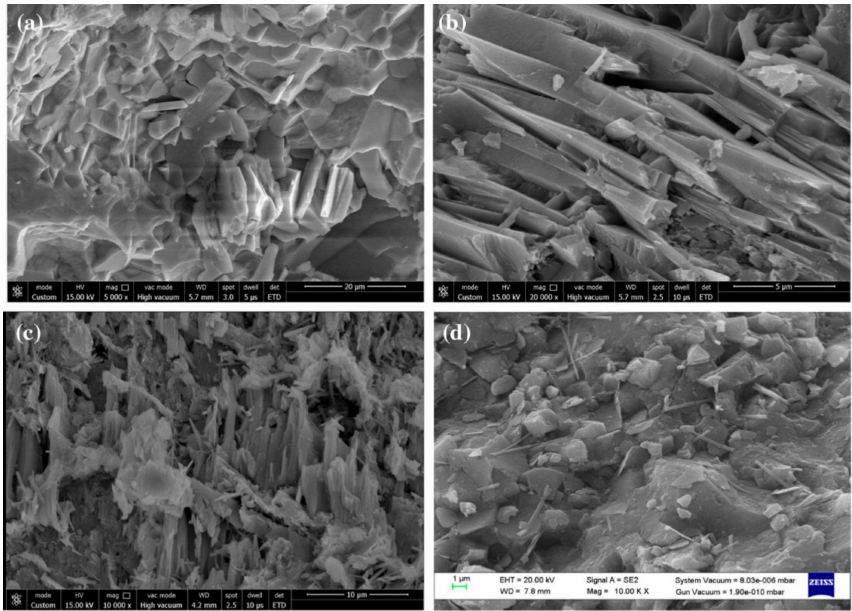
Figure 35. FE-SEM images of CNC specimens incorporating ( a ) 0.02% SP@GO, ( b ) 0.04% SP@GO, ( c ) 0.08% SP@GO and ( d ) 0.16% SP@GO at curing age of 28 days. Reprinted with permission from [164]. Copyright © 2019, Elsevier